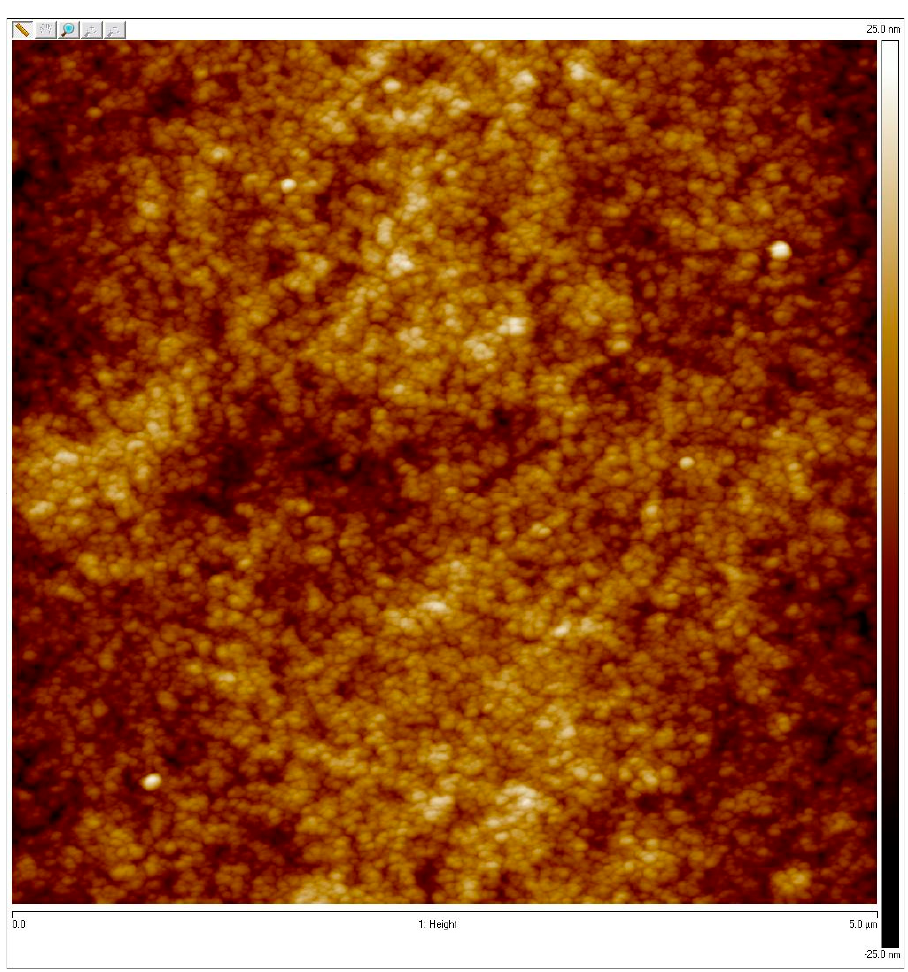
Figure 10. AFM visualization of (ALG—PFC) net layer deposited on the gold mica substrate cover. Chemical composition analysis of the cross - linked (ALG-PFC) net samples by X-ray spectrometer (EDX) was performed using an EDX analyzer. (ALG-PFC) net mapping images in the spectra show the characteristic elements for perfluorooctyl and the cross - linking factor. There were mean values obtained: O: 11.88 ± 4.50; F: 0.25 ± 0.01; Ca: 26.42 ± 3.55; Cl: 51.61 ± 6.47. A representative image of the spectrum is presented in Figure 11. The obtained results confirmed the presence of oxygenating and cross-linking factors.